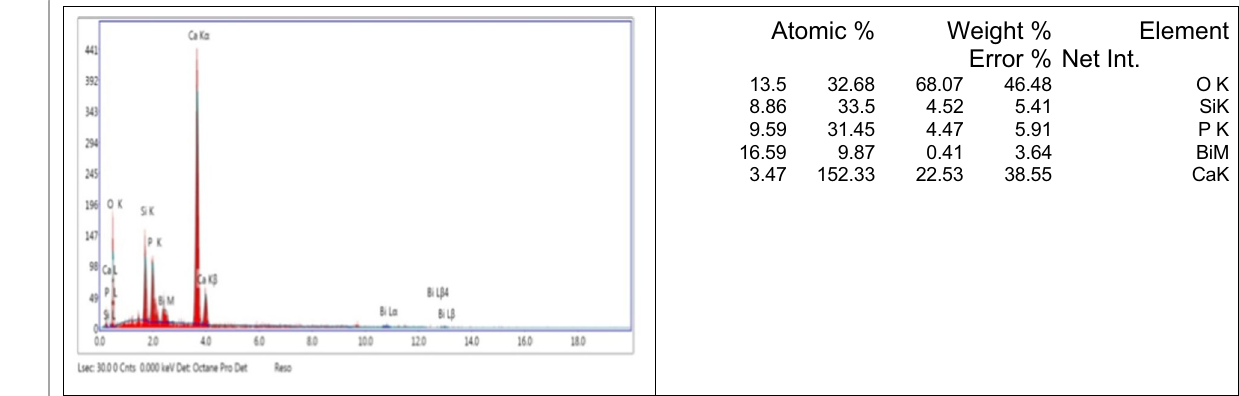
Fig. 11 EDAX analysis of 14-day sample cured in distilled water (DW)